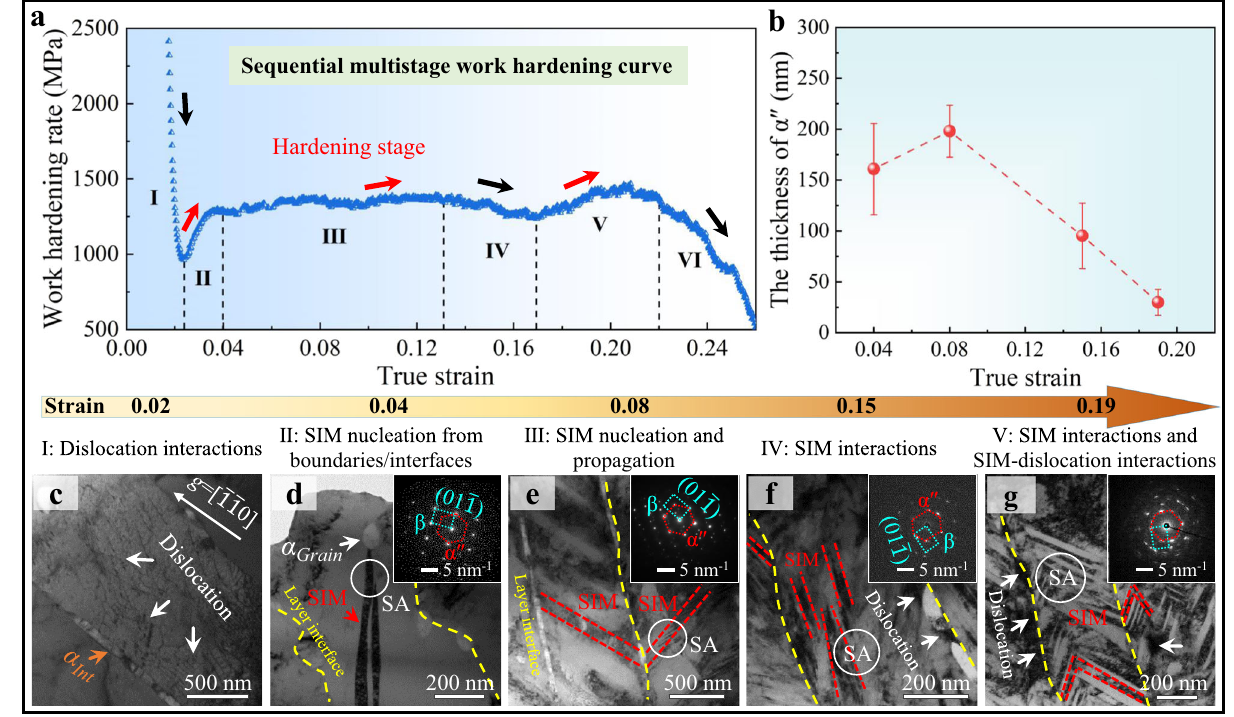
Fig. 6 | The multistage work-hardening behavior and the underlying mechanismsinHLS-0.43 β -Tialloys.a Arepresentativework-hardeningratecurve of HLS-0.43 β -Tialloys. b Pro fi lesof martensiticthickness vs .truestrain,revealinga maximum thickness of martensitic plates at a strain of ε =0.08. Below this strain, martensites have just nucleated so that they can grow up to large thickness with increasing ε ; while beyond this strain these submicron-sized martensites interplay, leading to microstructural re fi nement and the formation/nucleation